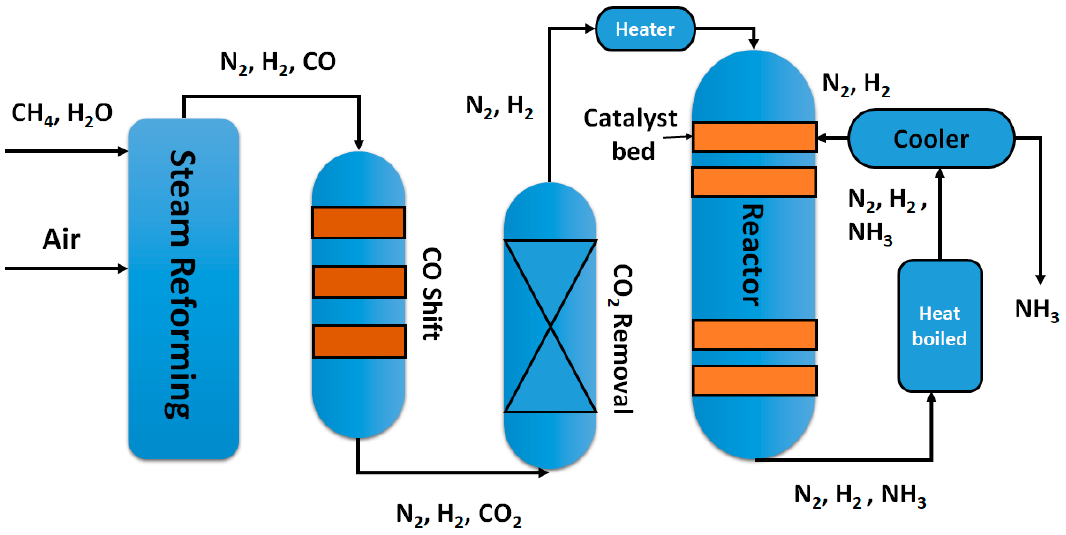
Figure 1. A flow scheme for the Haber-Bosch process.